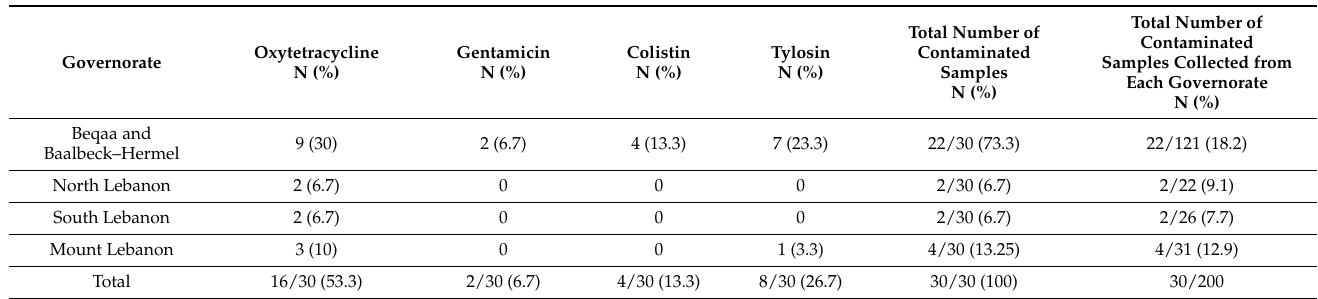
Table 5. Distribution of positive samples for antibiotic residues among the different Lebanese